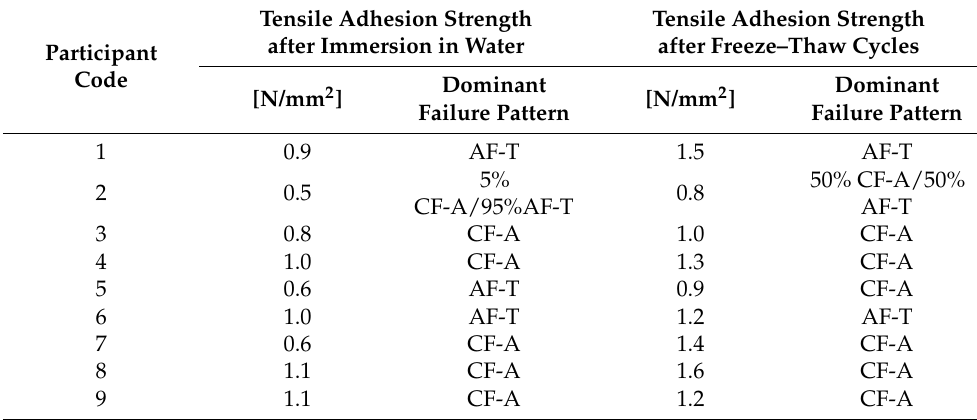
CF-A—cohesive failure within the adhesive, AF-T—adhesion failure between adhesive and tile, AF-S—adhesion failure between adhesive and substrate, CF-S—cohesive failure in the substrate, CF-T—cohesive failure in the tile or BT—adhesive failure between tile and pull head plate. Table 2. The tensile adhesion strength after immersion in water and tensile adhesion strength after freeze–thaw cycles of CTA with the predominant mode of failure obtained by 27 laboratories in the 12th ed. of